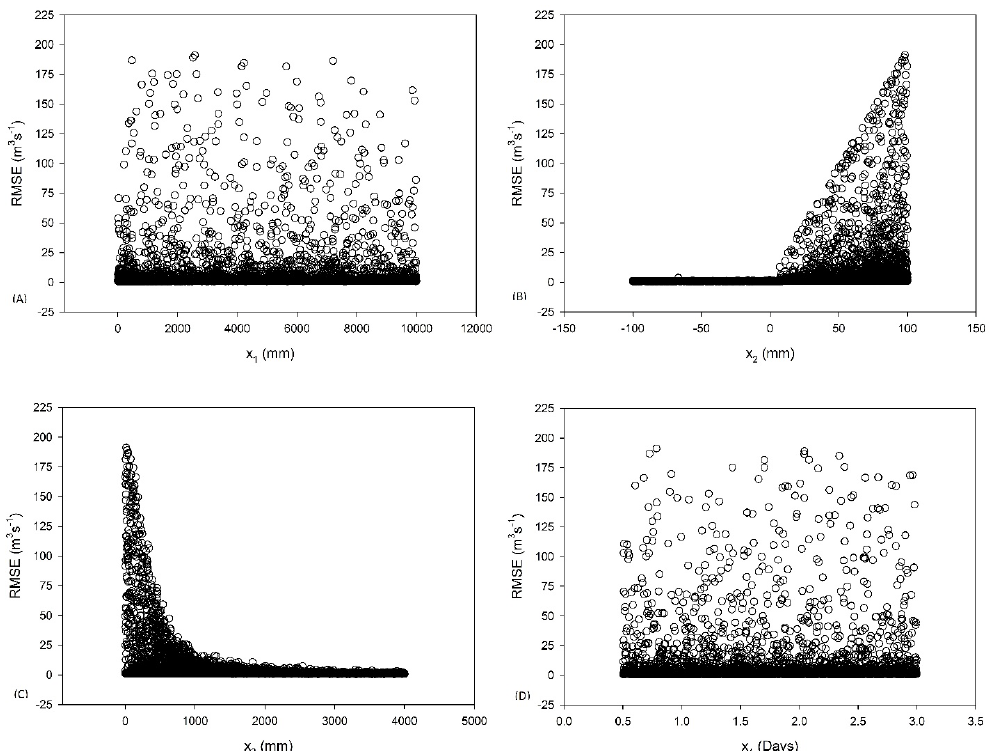
Figure A1. Scatter plots between the RMSE efficiency statistic ( Y -axis) and the parameter values: ( A ) X 1 , ( B ) X 2 , ( C ) X 3 and ( D ) X 4 , for the GR4J hydrological model.